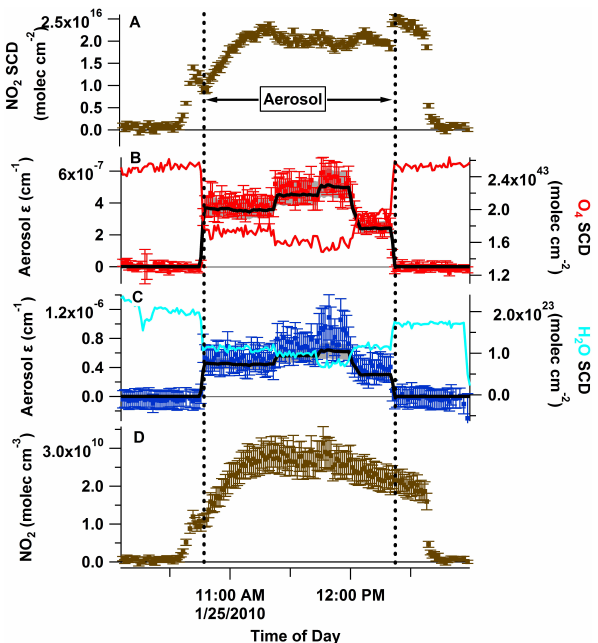
Fig. 8. Simultaneous retrieval of NO 2 and aerosol extinction at two wavelengths in closed cavity mode. (A) Retrieved NO 2 slant column density. (B) O 4 SCD (Red Line) and aerosol extinction retrieved from O 4 absorption at 477nm (red dots) compared to Mie theory (black line, gray area represents uncertainty in size of 350nmPSLs); (C) H 2 O SCD and aerosol extinction retrieved from water absorption at 442.8nm (blue dots) compared to theory (black line); (D) NO 2 concentration corrected for the change in path length measured using O 4